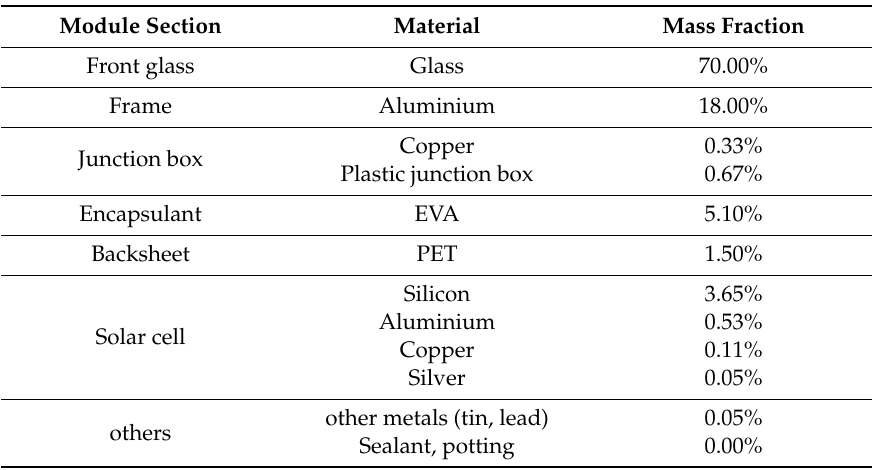
Table 2. Mass composition of c-Si module input waste.